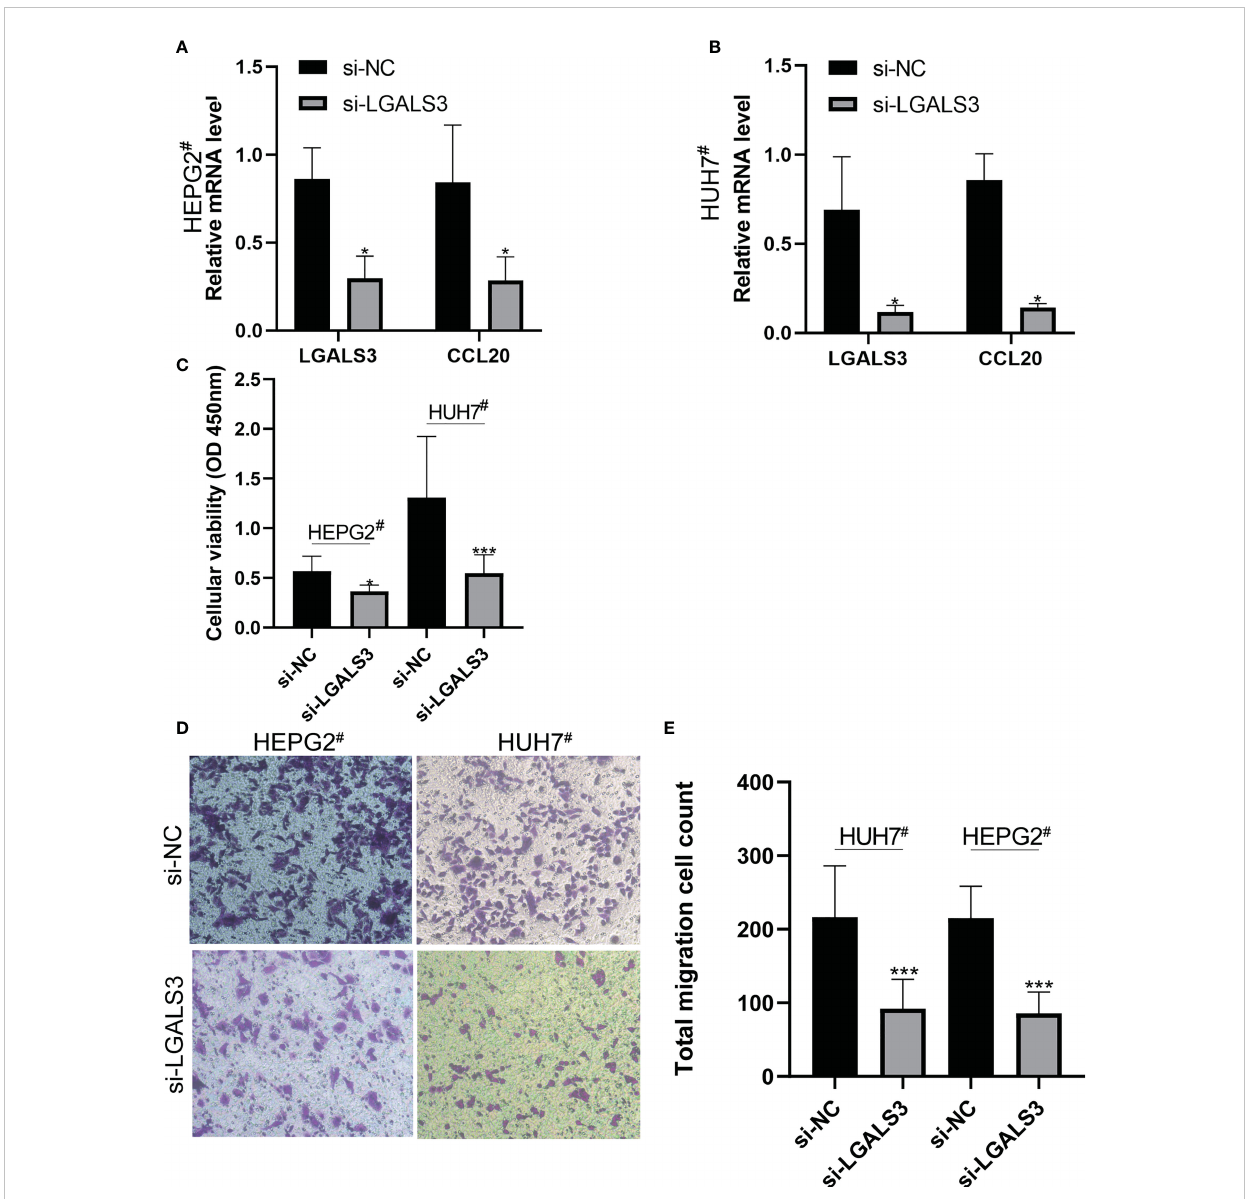
FIGURE 11 LGALS3 knockdown affects the proliferation and migration of hepatocellular carcinoma cells and the expression of CCL20. (A) Changes of CCL20 before and after LGALS3 knockdown in HEPG2 # . (B) Changes of CCL20 before and after LGALS3 knockdown in HUH7 # . (C) Cell proliferation before and after knockdown was detected by CCK8. (D, E) Transwell assay showed that cell migration ability decreased after LGALS3 knockdown. * P < 0.05, *** P <